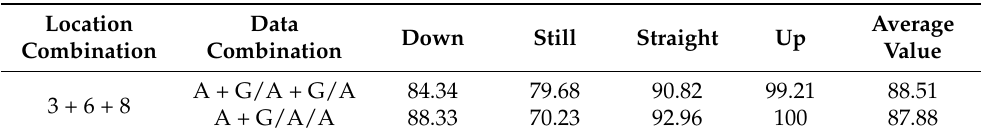
Table 8. F-measure value of the best recognition model of three-position fusion inertial sensors— Classified lifting